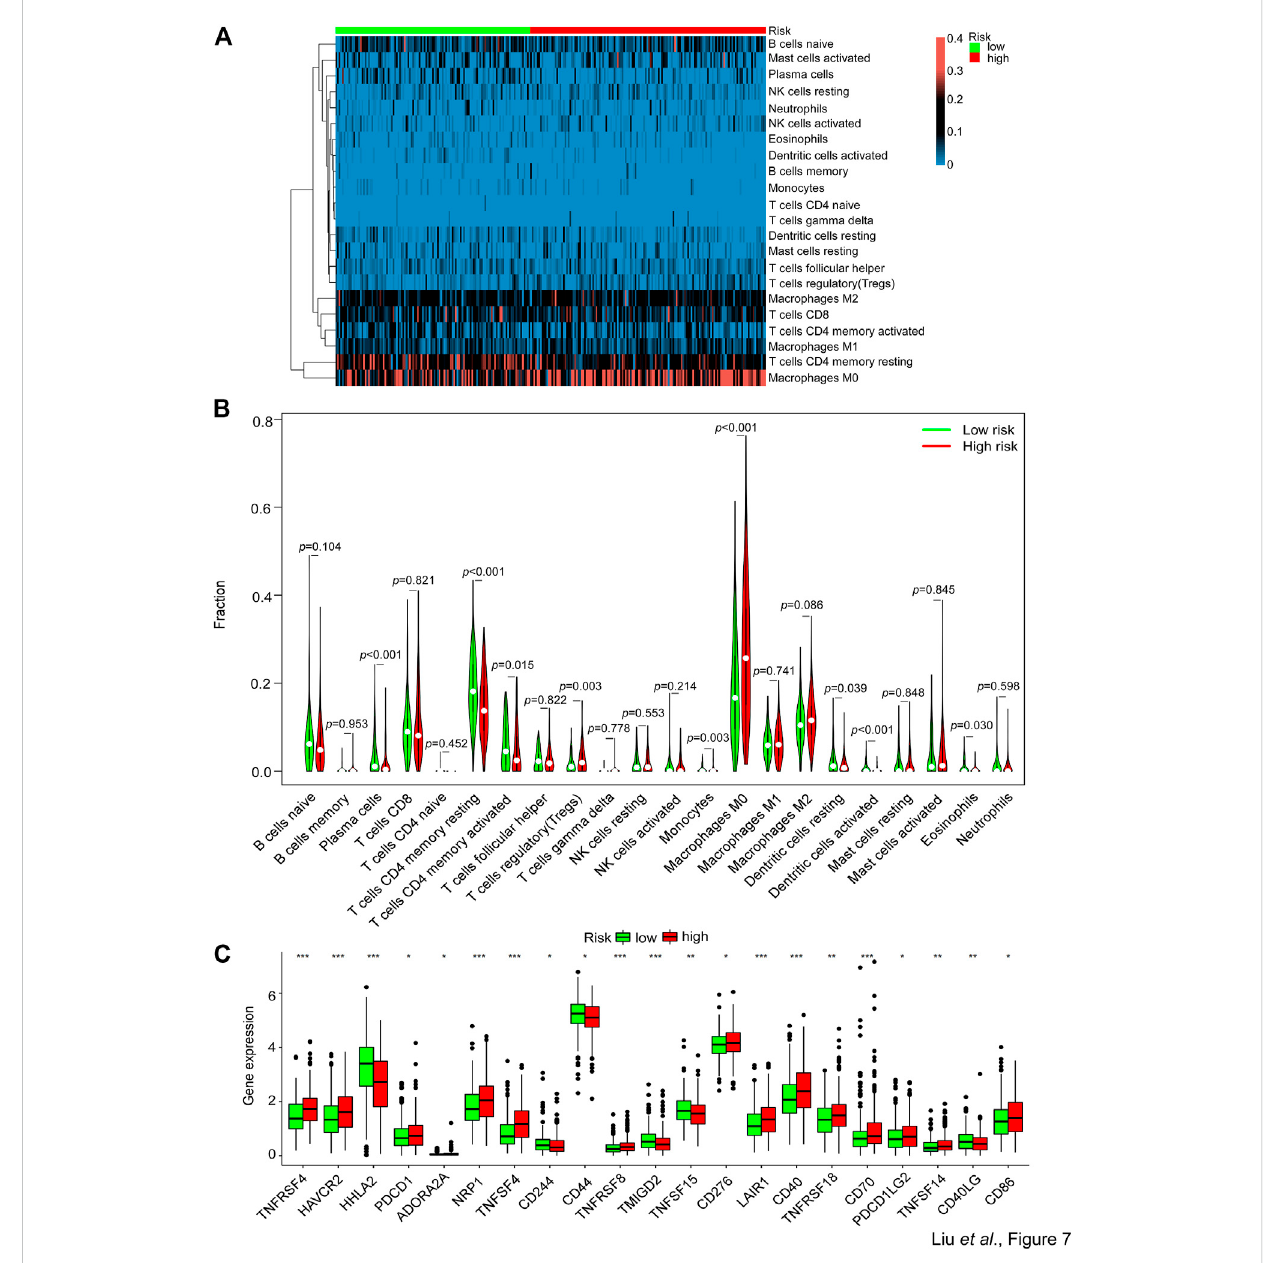
FIGURE 7 Comparison of the immune analysis between different risk groups. (A,B) The mRNA expression from the TCGA-CRC dataset was used to perform immune cells analyses by CIBERSORT. The immune cells ’ relative fraction was used to generate the (A) heatmap and (B) vioplot in the high- or low-risk groups. Wilcox test was used to compare the relative fraction between two groups. (C) The whole TCGA-CRC dataset was used to analyze the mRNA expression levels of selected immune checkpoints genes in high- and low-risk groups. Adjusted p values were shown as: ns, not signi fi cant; * p < 0.05; ** p < 0.01; *** p <